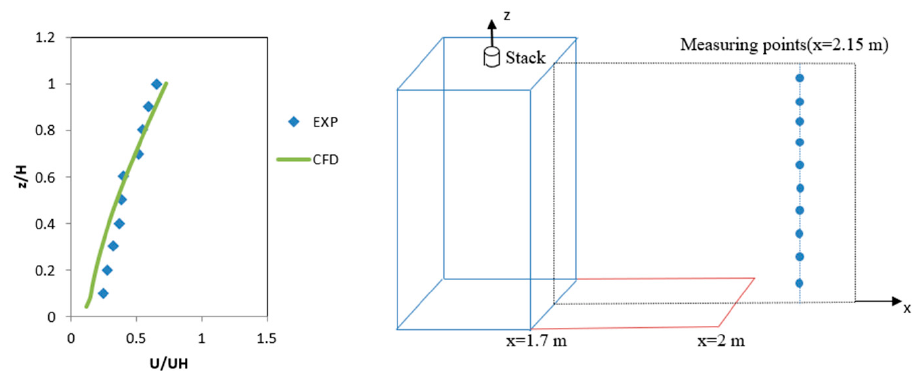
Figure 6. Velocity measuring points on the y = 0 m plane.